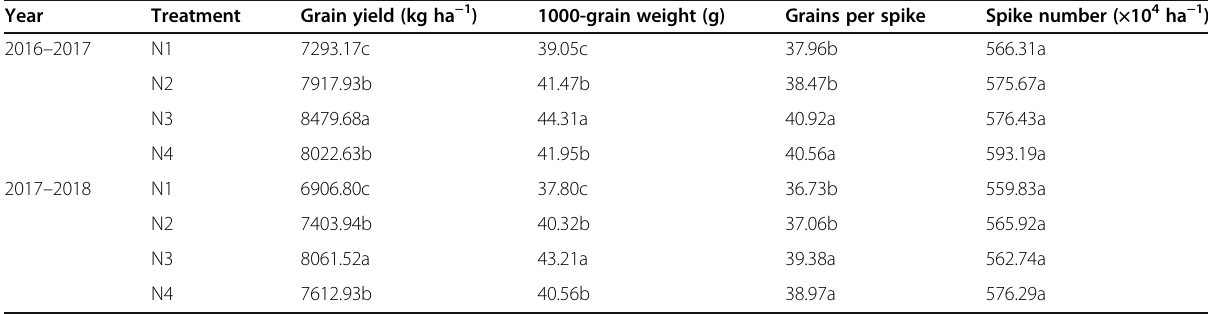
Table 3 Effects of four split nitrogen fertilizer treatments on grain yield and components at maturity. Different letters in each column represent significant differences in each tissue among four treatments at each sampling date according to LSD at 5%